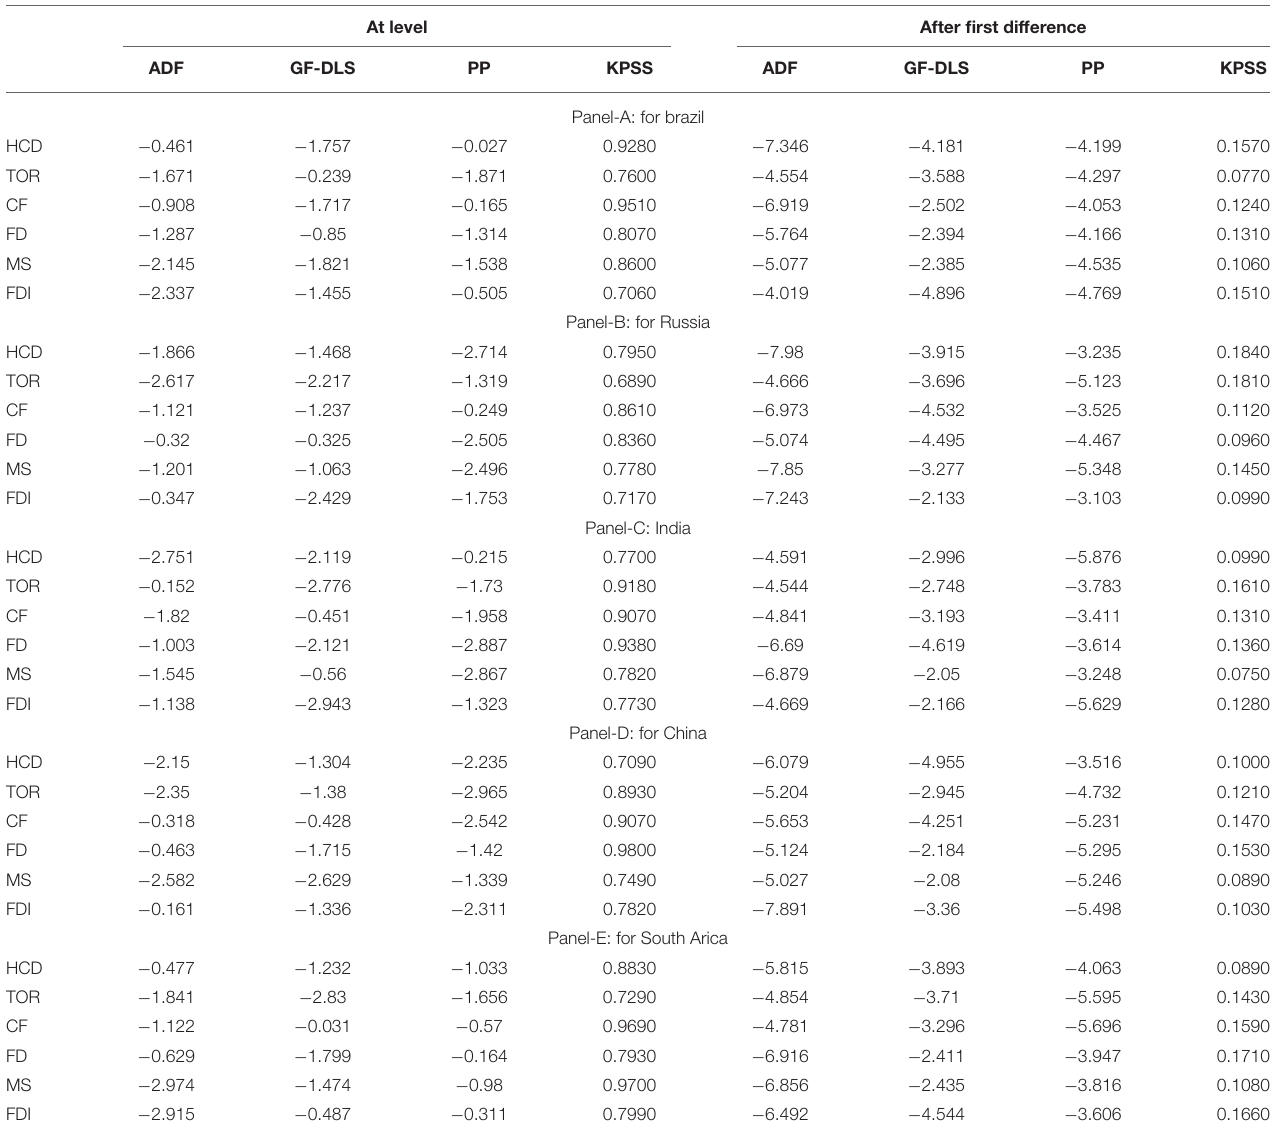
TABLE 3 | Results of conventional unit root test.